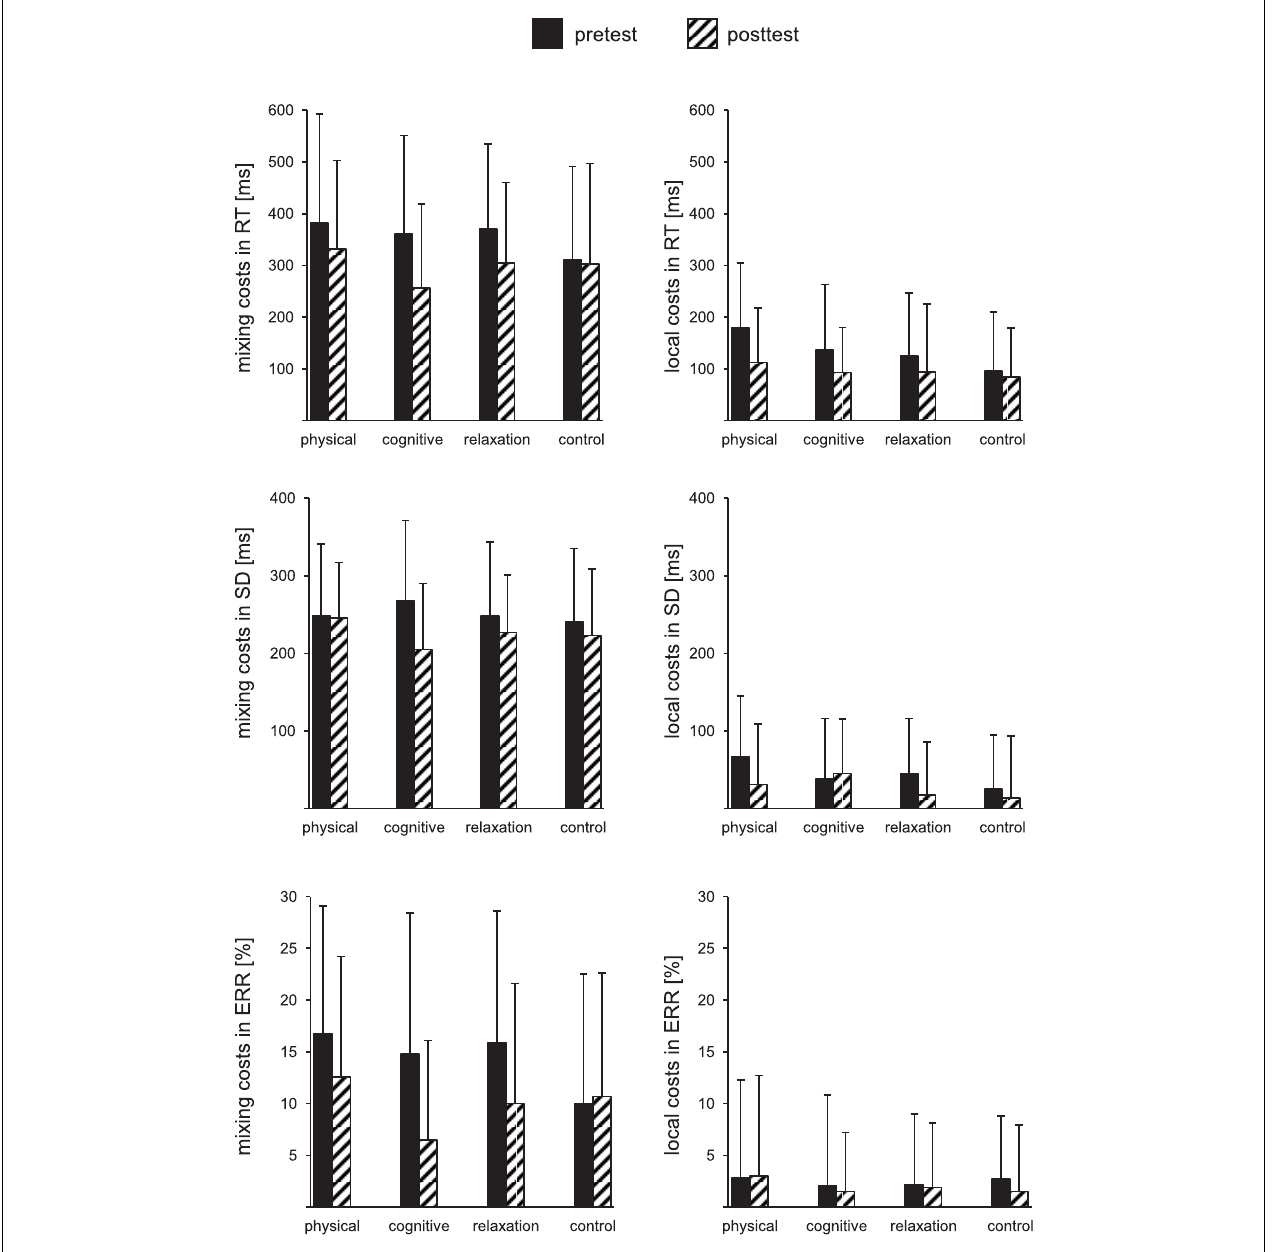
FIGURE 2 | Mixing costs (left) and local costs (right) expressed as the mean reaction times (RT), mean standard deviations (SD), and mean error rates (ERR) for pre- and post-test and each group. The error bars reflect standard deviation.